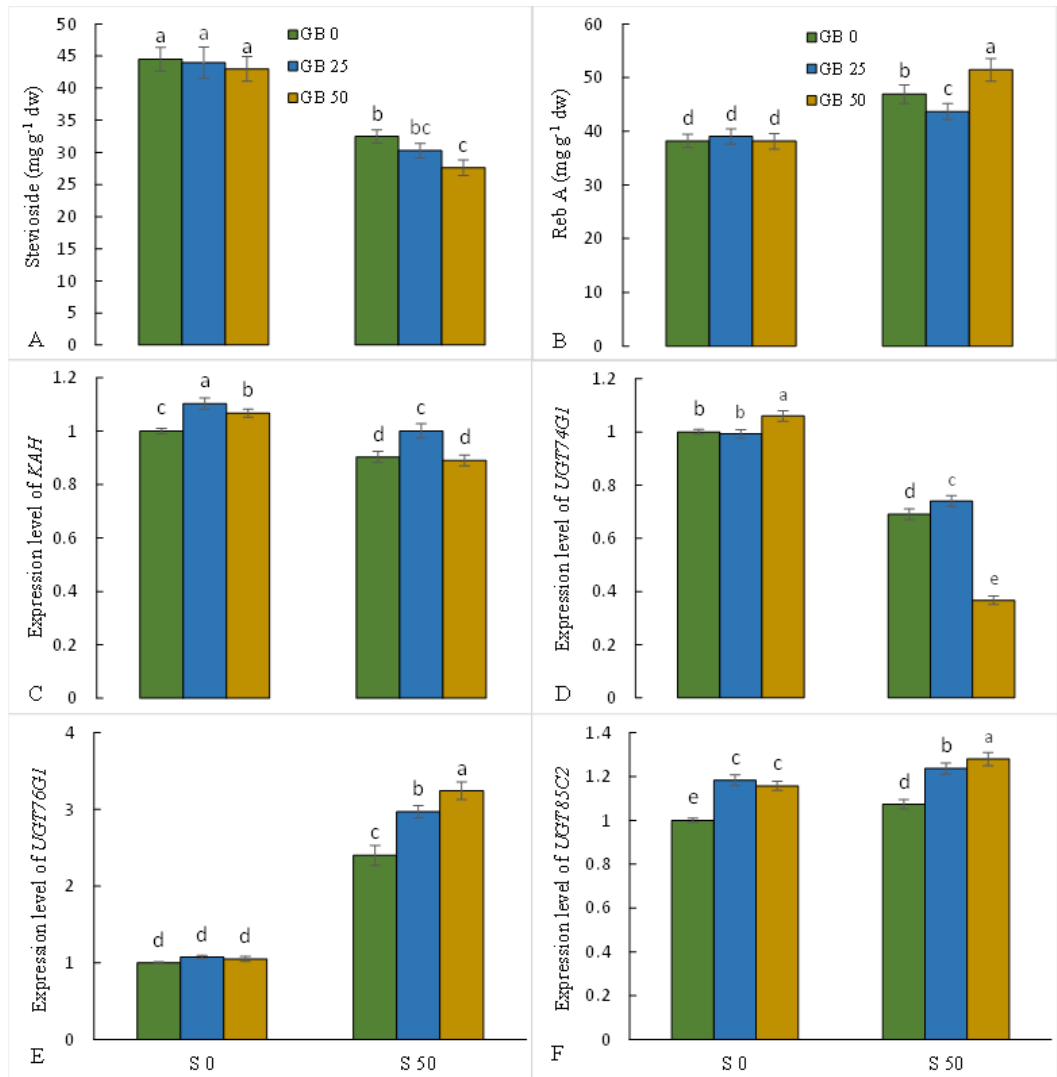
Figure 6. Effect of glycine betaine (GB, 0 and 50 mM) on the content of stevioside ( A ) and rebaudioside (Reb) A ( B ) and the expression level of the KAH ( C ), UGT74G1 ( D ), UGT76G1 ( E ), and UGT85C2 ( F ) genes of stevia leaves under NaCl (0, 25, and 50 mM) treatment. Values (means ± SD) followed by the same letter are not significantly different ( p < 0.05; Duncan test).